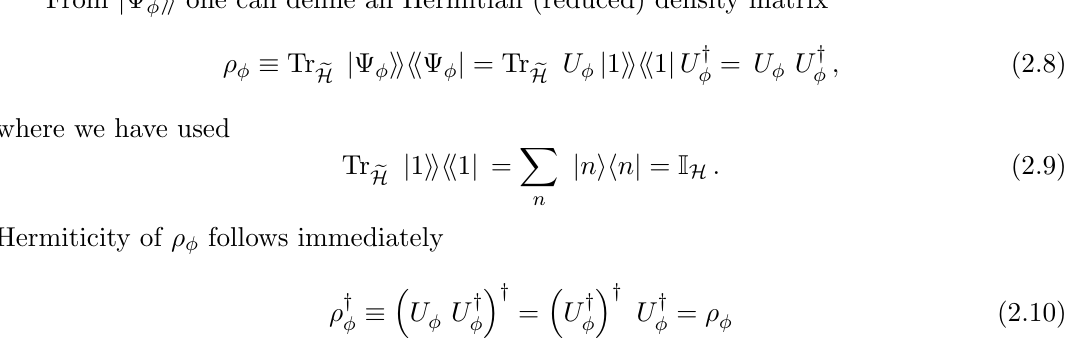
Figure 2 . (a) A (cid:12)nite Euclidean time evolution depicted in terms of matrix elements h n j U (cid:30) j m i . (b) The same geometry can be also understood as the component ( h n j (cid:10) h ~ m j ) j (cid:9) (cid:30) ii of a ket j (cid:9) (cid:30) ii de(cid:12)ned in the TFD Hilbert space H (cid:10) ~ H . This can be veri(cid:12)ed by noticing that h ~ m j ( U is schematically represented in (cid:12)gure 2: U ator on a single Hilbert space, and the corresponding TFD-ket j (cid:9) right with its two ends now representing the d.o.f. of the TFD double intersected at some spacelike surface of (cid:12)xed time t